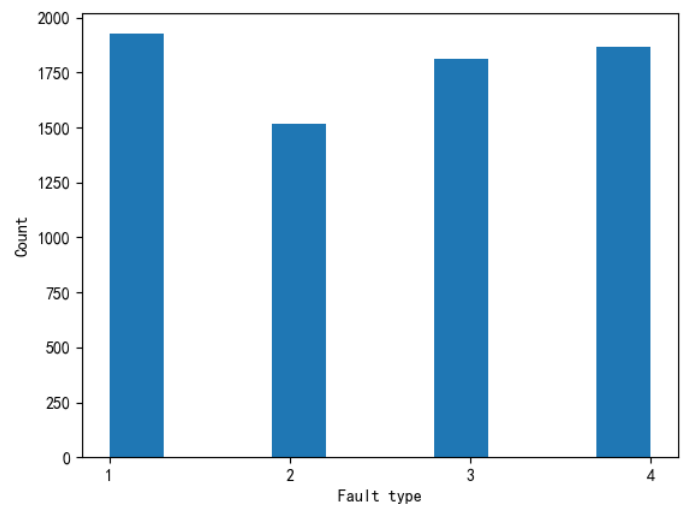
Figure 3. Distribution of the fault types in source